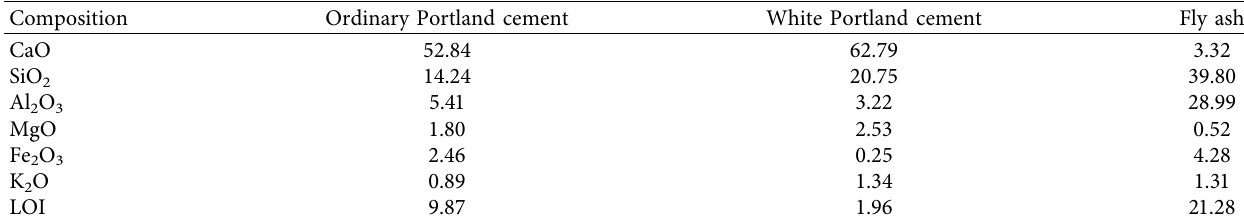
Table 1: Main chemical composition of cementitious materials